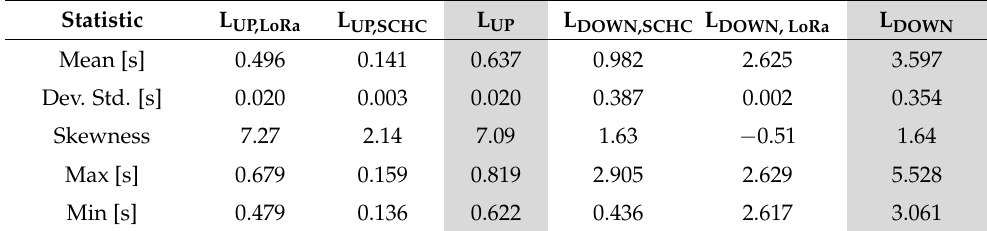
Table 4. Statics of metrics evaluated when the LoRaWAN backend is located in South Carolina. Statistic L UP,LoRa L UP,SCHC L UP L DOWN,SCHC L DOWN, LoRa L DOWN Mean